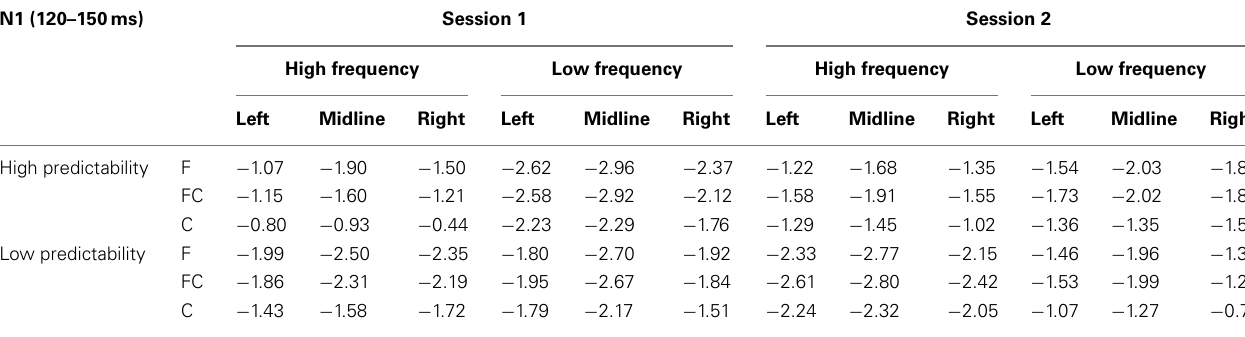
Table 2 | Mean amplitudes of anterior N1 for each condition and each electrode of interest in each session. N1